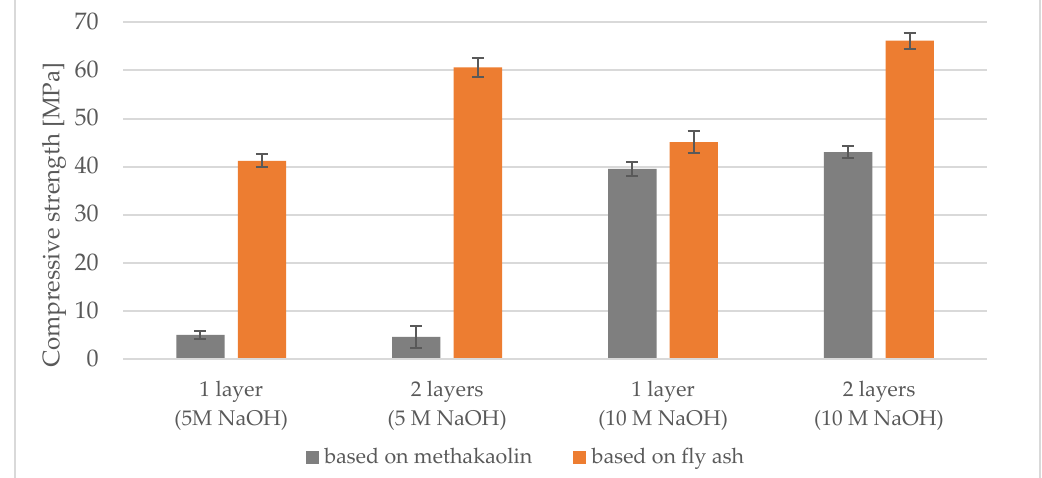
Figure 16. Compressive strength for metakaolin and fly ash-based geopolymers reinforced with a basalt grid.